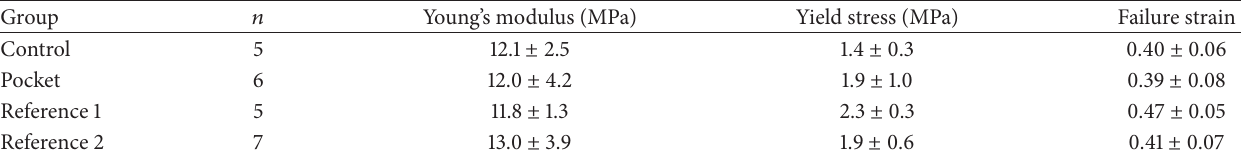
Table 1: Number of sample data sets ( 𝑛 ), Young’s modulus, yield stress, and failure strain obtained in each one of the